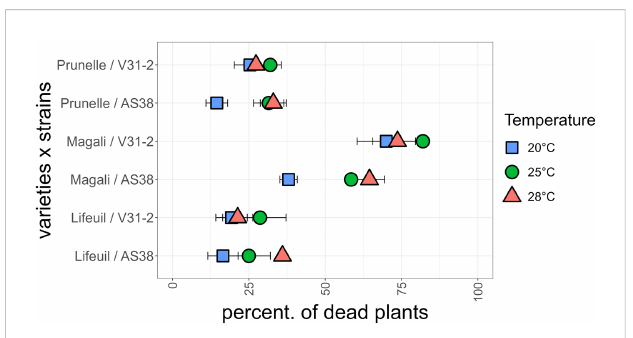
FIGURE 7 Mortality at the end of the experiment for three M. sativa varieties (Prunelle, Magali and Lifeuil) infected with V. alfalfae V31-2 and its derived mutant AS38, each at three temperatures. Data for each combination are from three independent experiments, each with 100 plants per variety. Bars indicate standard error of observed